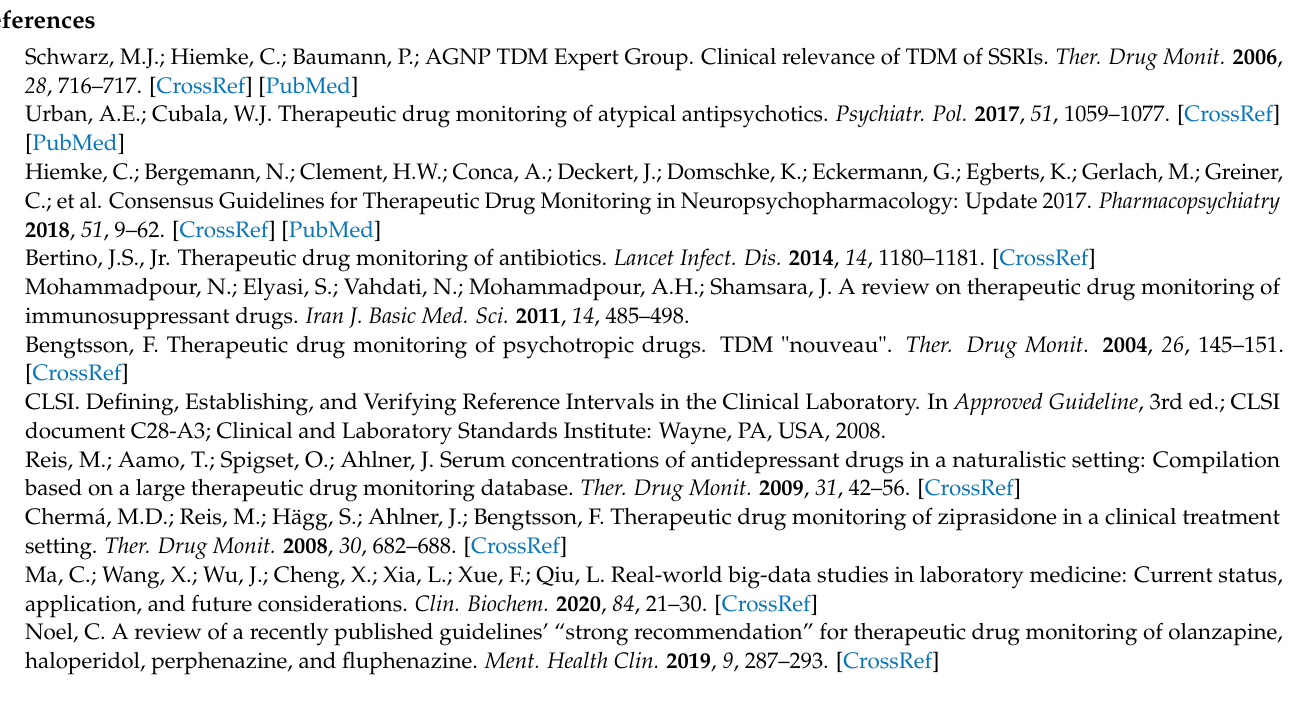
data, Table S2: Table 2—Supplementary data, Table S3: Table 3—Supplementary data, Table S4: Table 4—Supplementary data, Table S5: Table 5—Supplementary data. The RefIT software v1 can be downloaded at